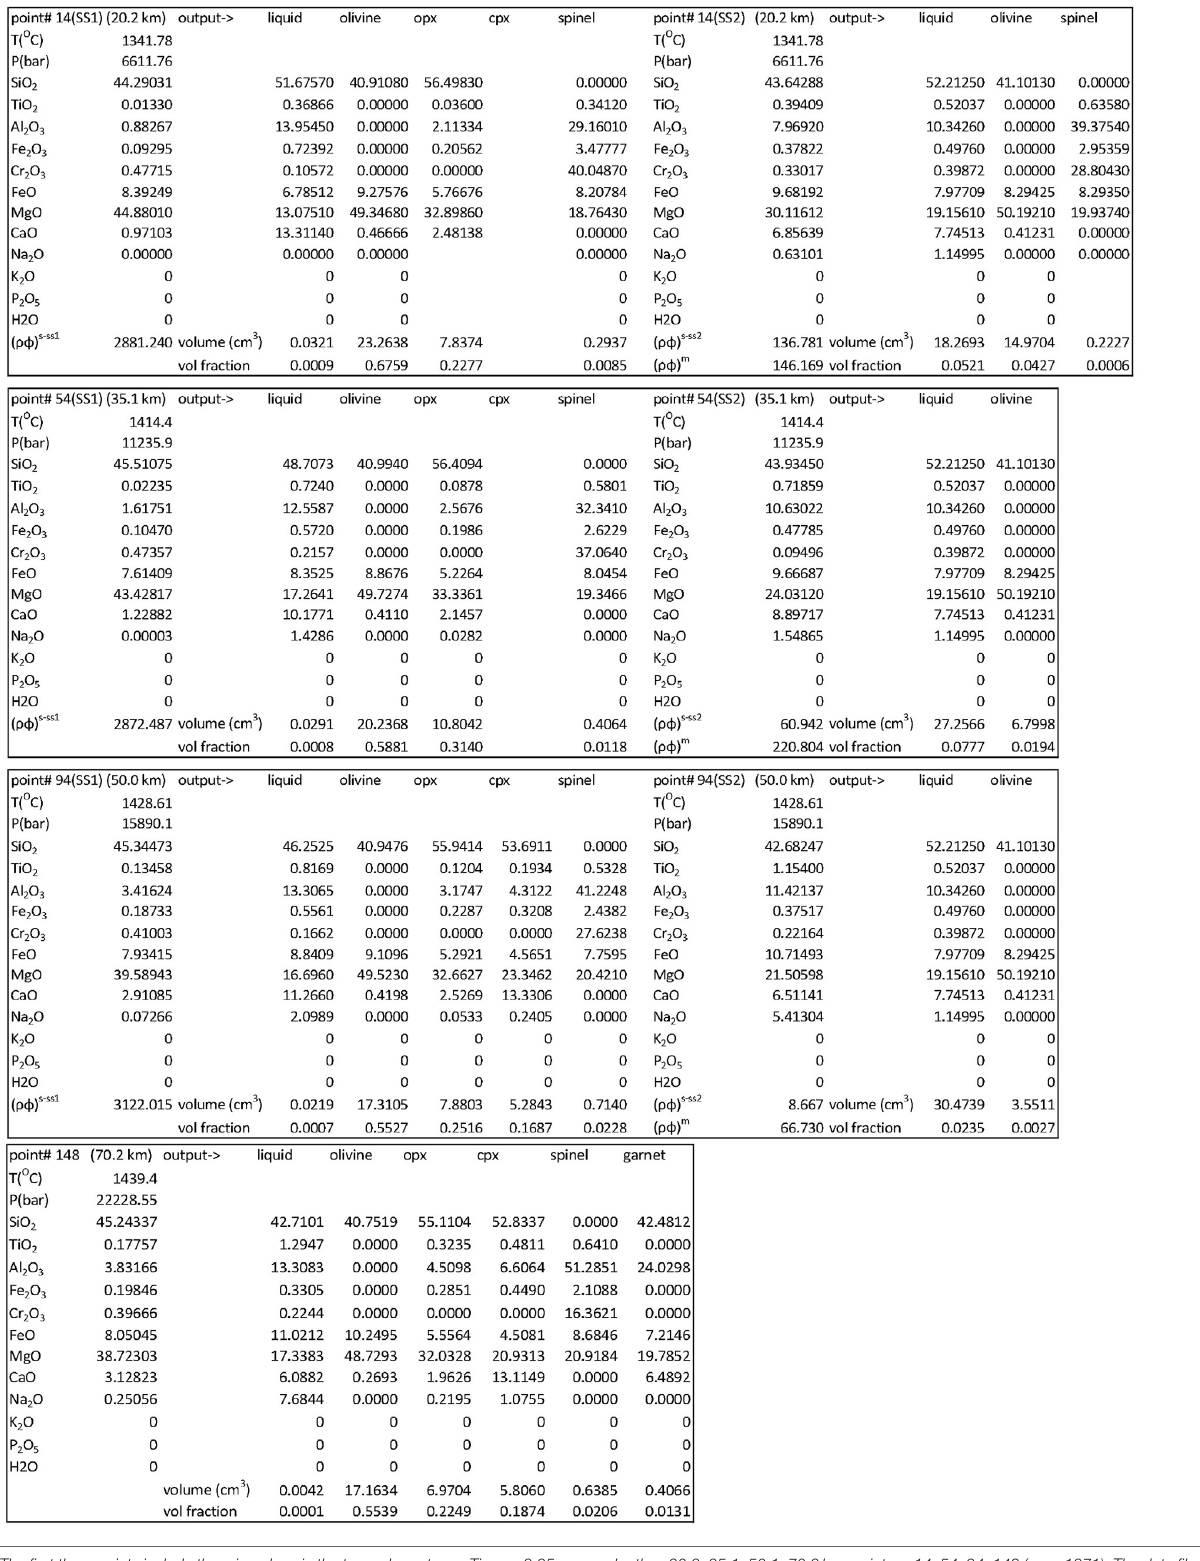
Thefirstthreepointsincludethemineralogy inthetwosub-systems. Time = 2.35myear, depth = 20.2,35.1,50.1,70.2km, points = 14,54,94,148(zone1271). Thedatafileproviding the input bulk composition, pressure and temperature is included in the zip file max-front2-data.zip